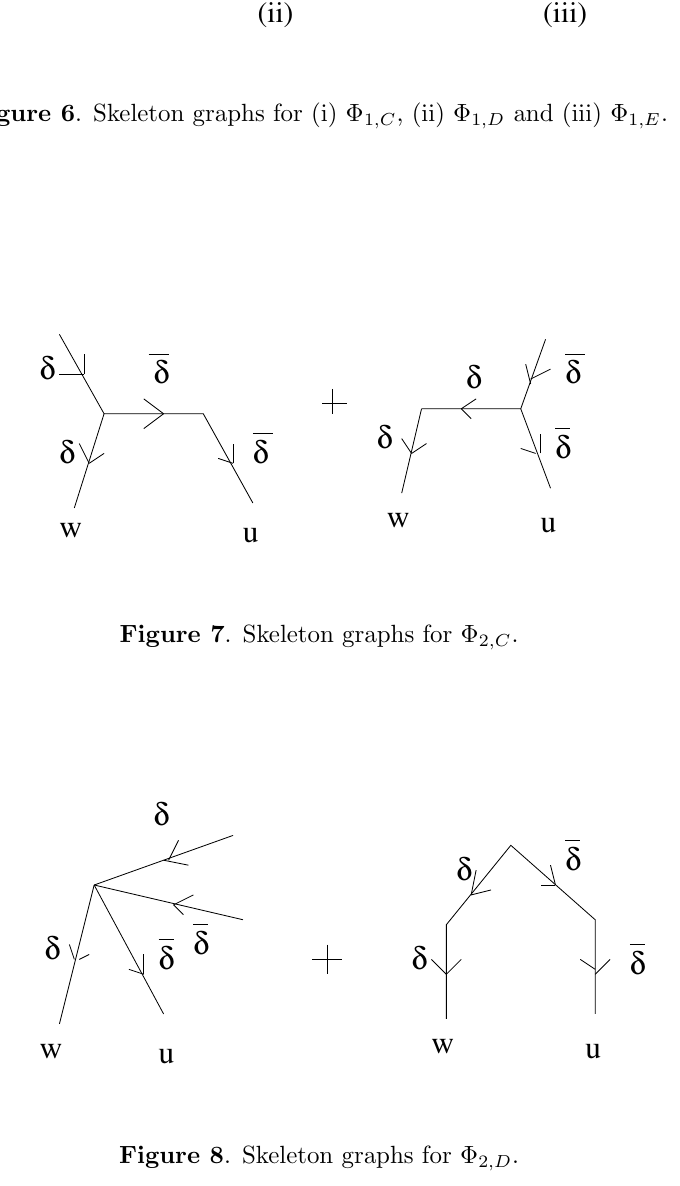
Figure 8 . Skeleton graphs for (cid:8) 2 ;D